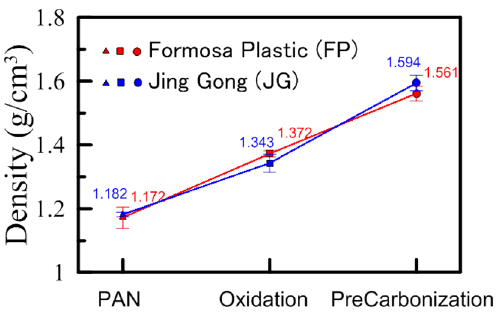
Figure 5. The densities of the fibers for three stages: PAN, oxidation, and pre-carbonization. The materials under test are obtained from Formosa Plastic Corporation (FP, red symbols) and Jing Gong Co., Ltd. (JG, blue